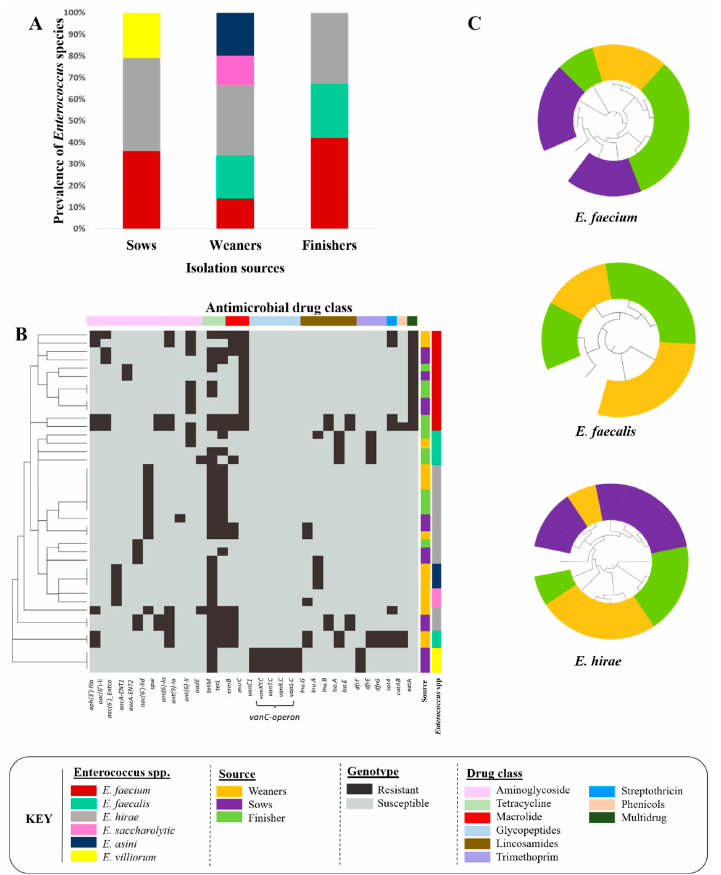
Figure 1. Enterococcus species recovered from fecal samples collected from sows ( n = 14), and wean- ing ( n = 15) and finishing ( n = 12) pigs. ( A ) Prevalence of Enterococcus species. ( B ) Antimicrobial resistance gene profiles of Enterococcus isolates. ( C ) Core-genome-based phylogenetic tree of E. faecium ( n = 12), E. faecalis ( n = 6), and E. hirae ( n = 15) recovered from different pig production stages.